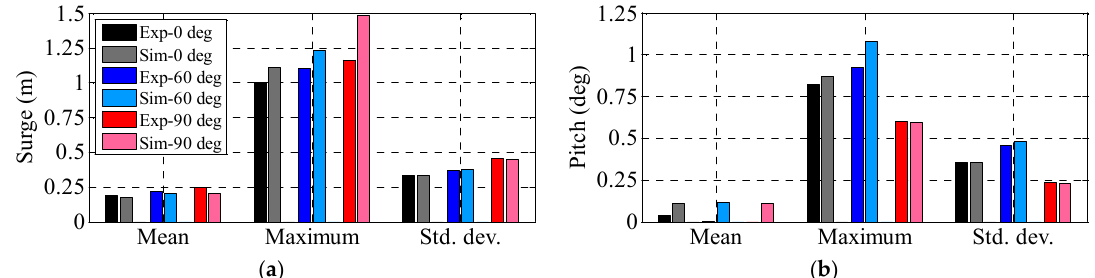
Figure 17. Statistical comparisons of the FAST simulation and model test data in three wave headings: ( a ) Surge motion; ( b ) Pitch motion.